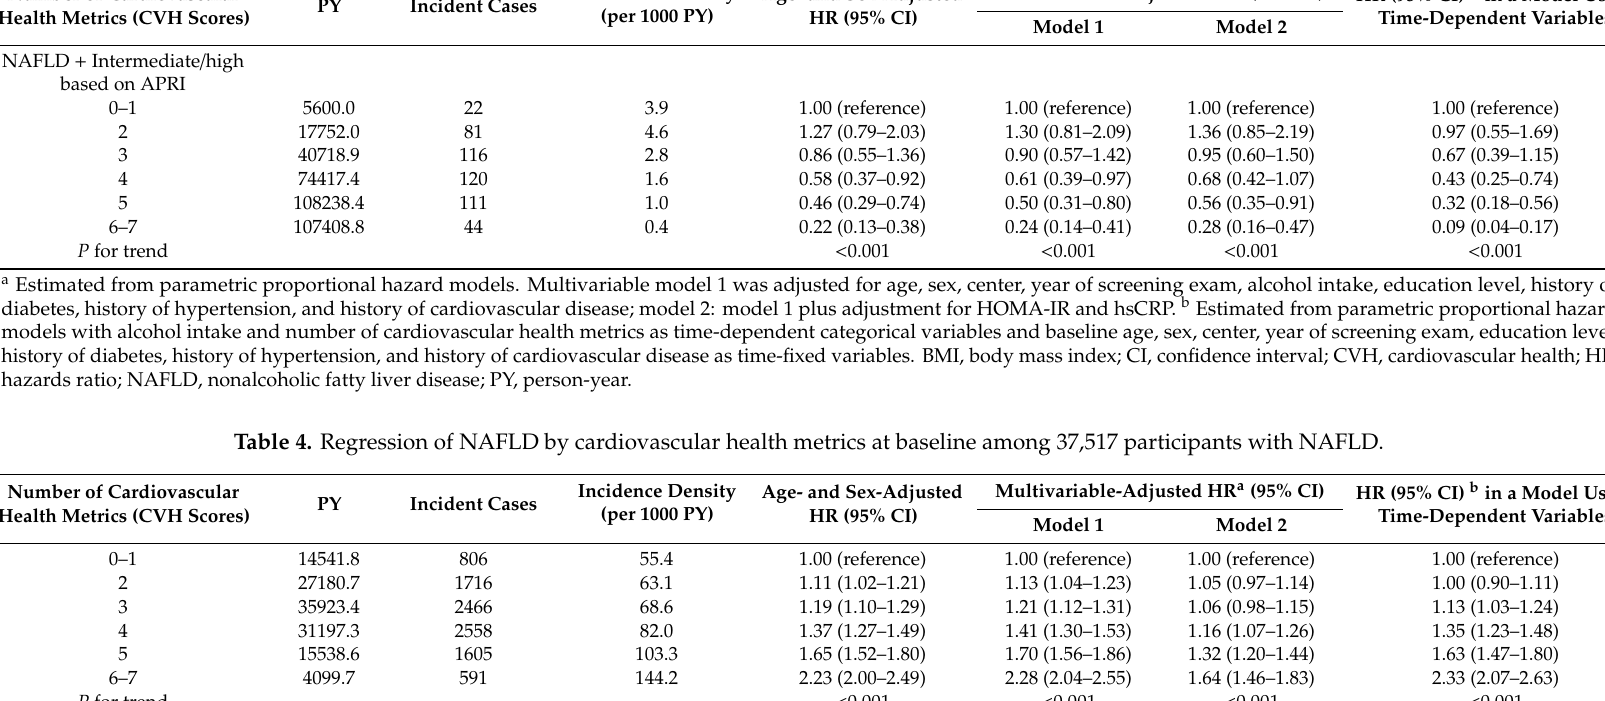
Table 3. Development of intermediate / high probability of advanced fibrosis based on APRI, and NAFLD plus intermediate / high probability of advanced fibrosis based on APRI by cardiovascular health metrics at baseline among 93,500 NAFLD-free participants with a low probability of advanced fibrosis at baseline. Number of Cardiovascular Health Metrics (CVH Scores)